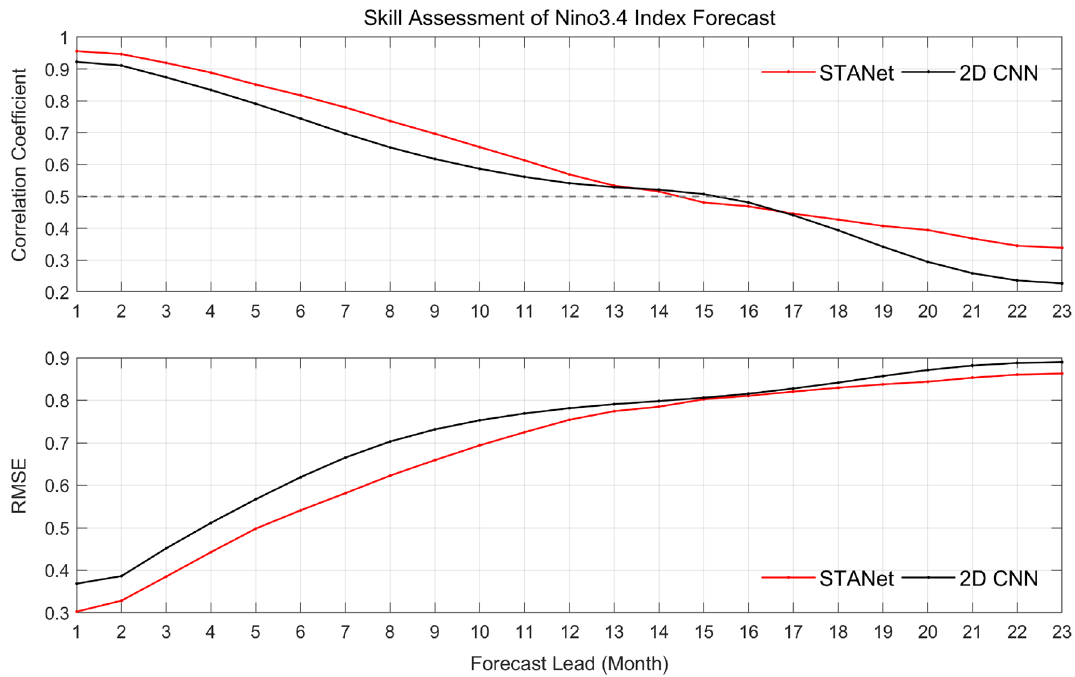
Figure 1. Time series of correlation coefficient ( CC ) and the root-mean-square-error ( RMSE ) for 23-month forecast lead time of the proposed STANet and the state-of-the-art 2D CNN model for the test period of